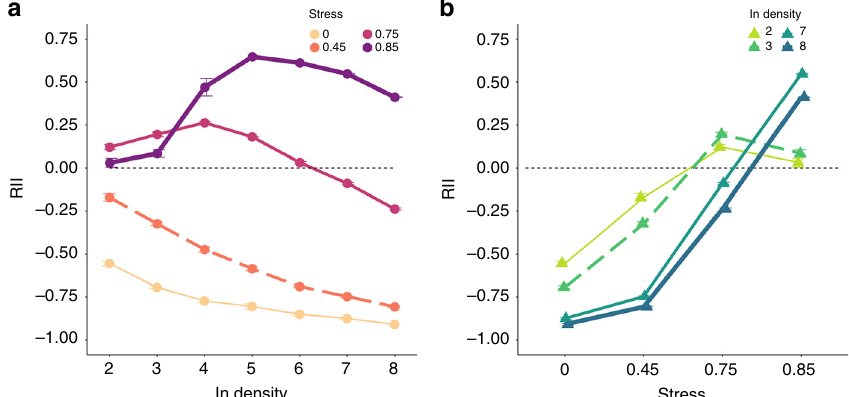
Fig. 2 The change of density-dependent interactions under stress in model simulations. a Relationship between initial density and relative interaction index (RII; data are presented as mean values ± SEM) in simulated populations growing along a stress gradient. b Plant – plant interactions change along the stress gradient, showing that the SGH applies at high densities but not at low densities. Circles represent different stress levels while triangles represent different density levels. N = 5 independent samples in model simulations for the density gradient from two to eight at each stress level. Note that for facilitating visual interpretation, we only show the two lowest and two highest densities (changes in the RII for intermediate densities were similar and ranged in between the extreme scenarios shown here). Source data are provided as a Source Data